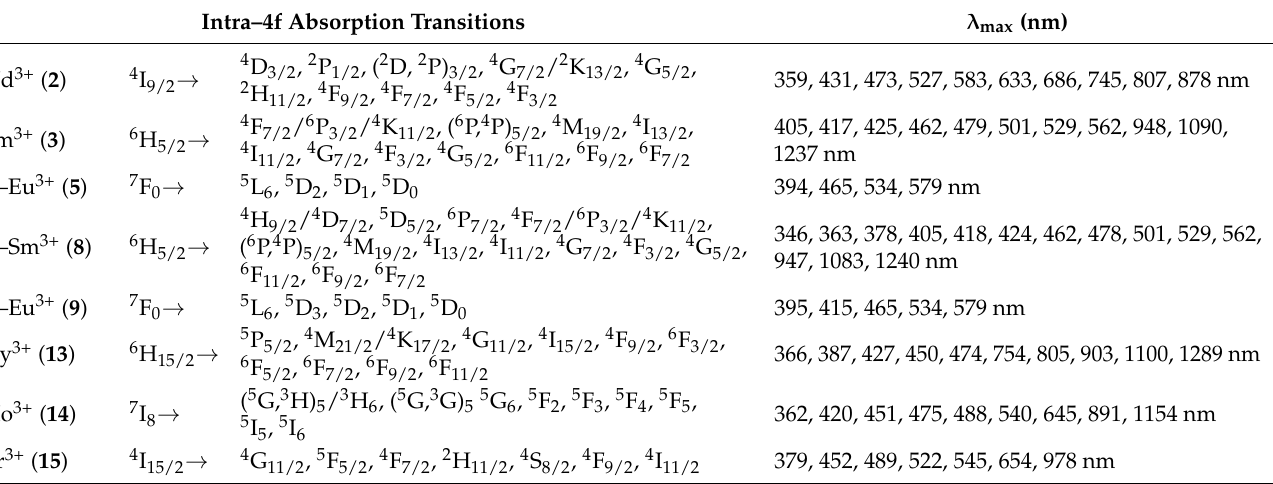
Table 1. Absorption wavelengths of the transitions of 1 ∞ [Ln 2 (2–PyPzH) 4 Cl 6 ], Ln = Nd ( 2 ), Sm ( 3